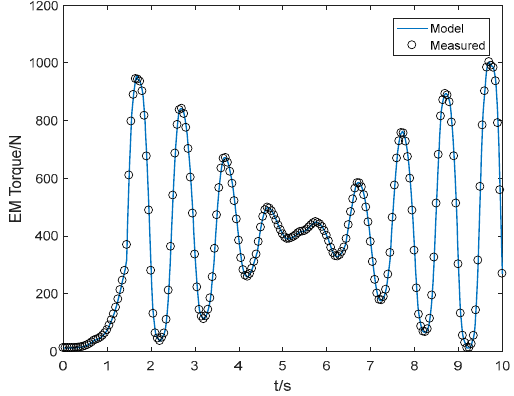
Figure 5. Input current and corresponding output force.